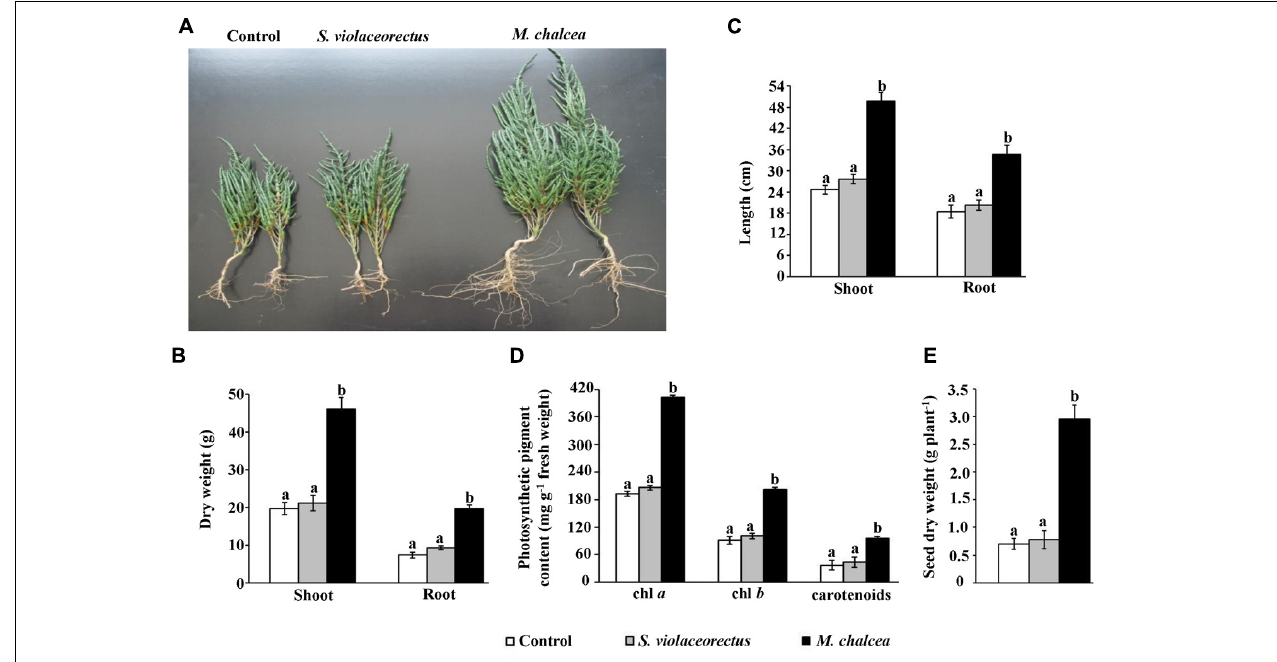
FIGURE 5 | Effect of application of Micromonospora chalcea UAE1 on Salicornia bigelovii tissues. Effect of autoclaved starch nitrate broth medium (control; left), the ACC deaminase-non-producing isolate Streptomyces violaceorectus UAE1 (isolate #22, middle) or the ACC deaminase-producing M. chalcea UAE1 (isolate #11, right) inoculations on the (A) shoot and root formation of S. bigelovii . Measurements of the shoot and root (B) dry weight, (C) length, and (D) contents of chlorophyll a (chl a ), chl b and carotenoids of S. bigelovii at 12 wpt. (E) Dry weight of S. bigelovii seeds harvested at 20 wpt. Seedlings growing in soil under evaporative-cooled greenhouse conditions, were inoculated using the pruned-root dip method. In (B–E) , values are means of 16 replicates ± SE for each sampling from two independent experiments. Mean values followed by different letters are significantly ( P < 0.05) different from each other according to Fisher’s Protected LSD Test. wpt, weeks post